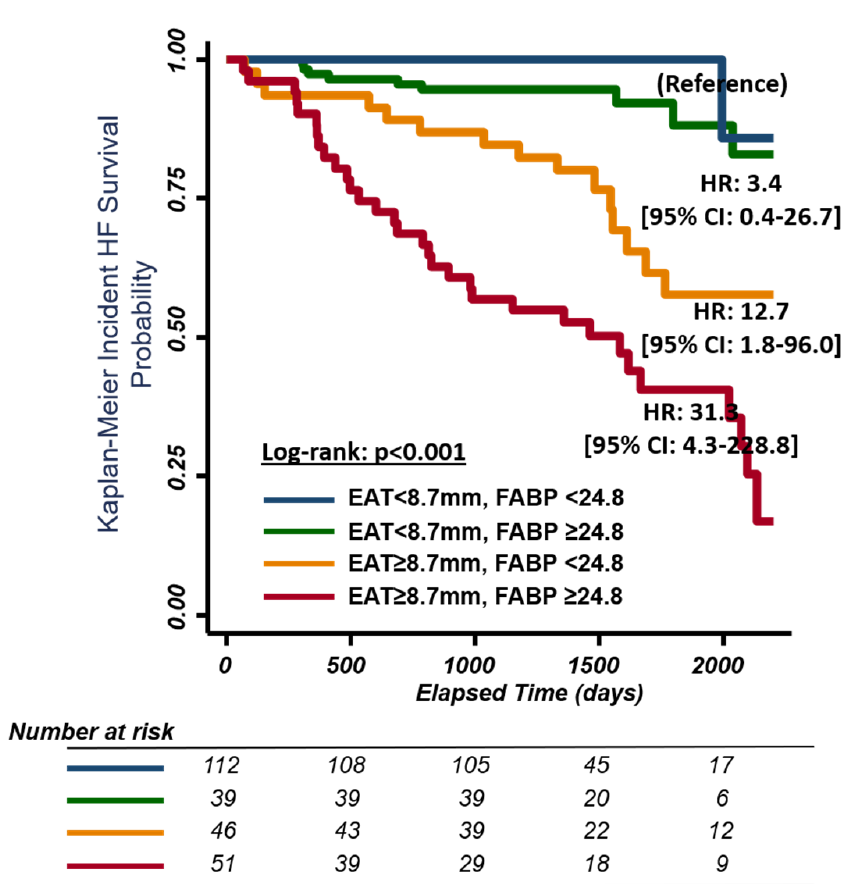
Figure 2. Kaplan–Meier curves for survival free of heart failure events (including heart failure hospitalization or death) stratified by EAT and A-FABP level. EAT, epicardial adipose tissue; FABP, fatty acid-binding protein. EAT cut-off point <8.7 mm and ≥ 8.7 mm. FABP cut-off point <24.8 mm and ≥ 24.8 mm. Table 3. Multivariate cox regression models in predicting hospitalization for HF events.